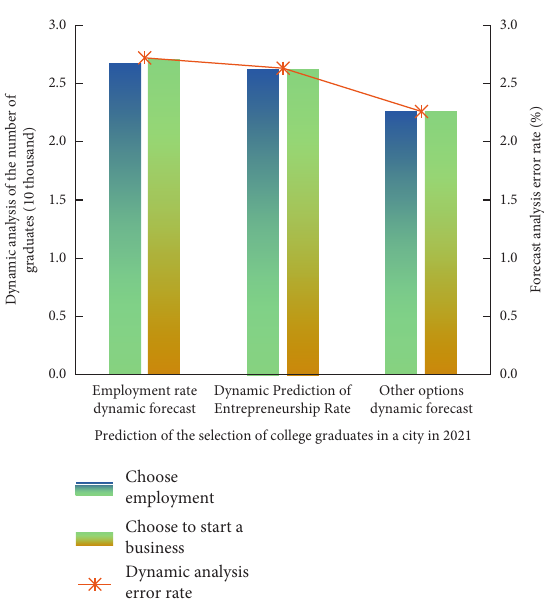
Figure 9: Dynamic prediction and error rate analysis of the se- lection of college graduates in a certain city in